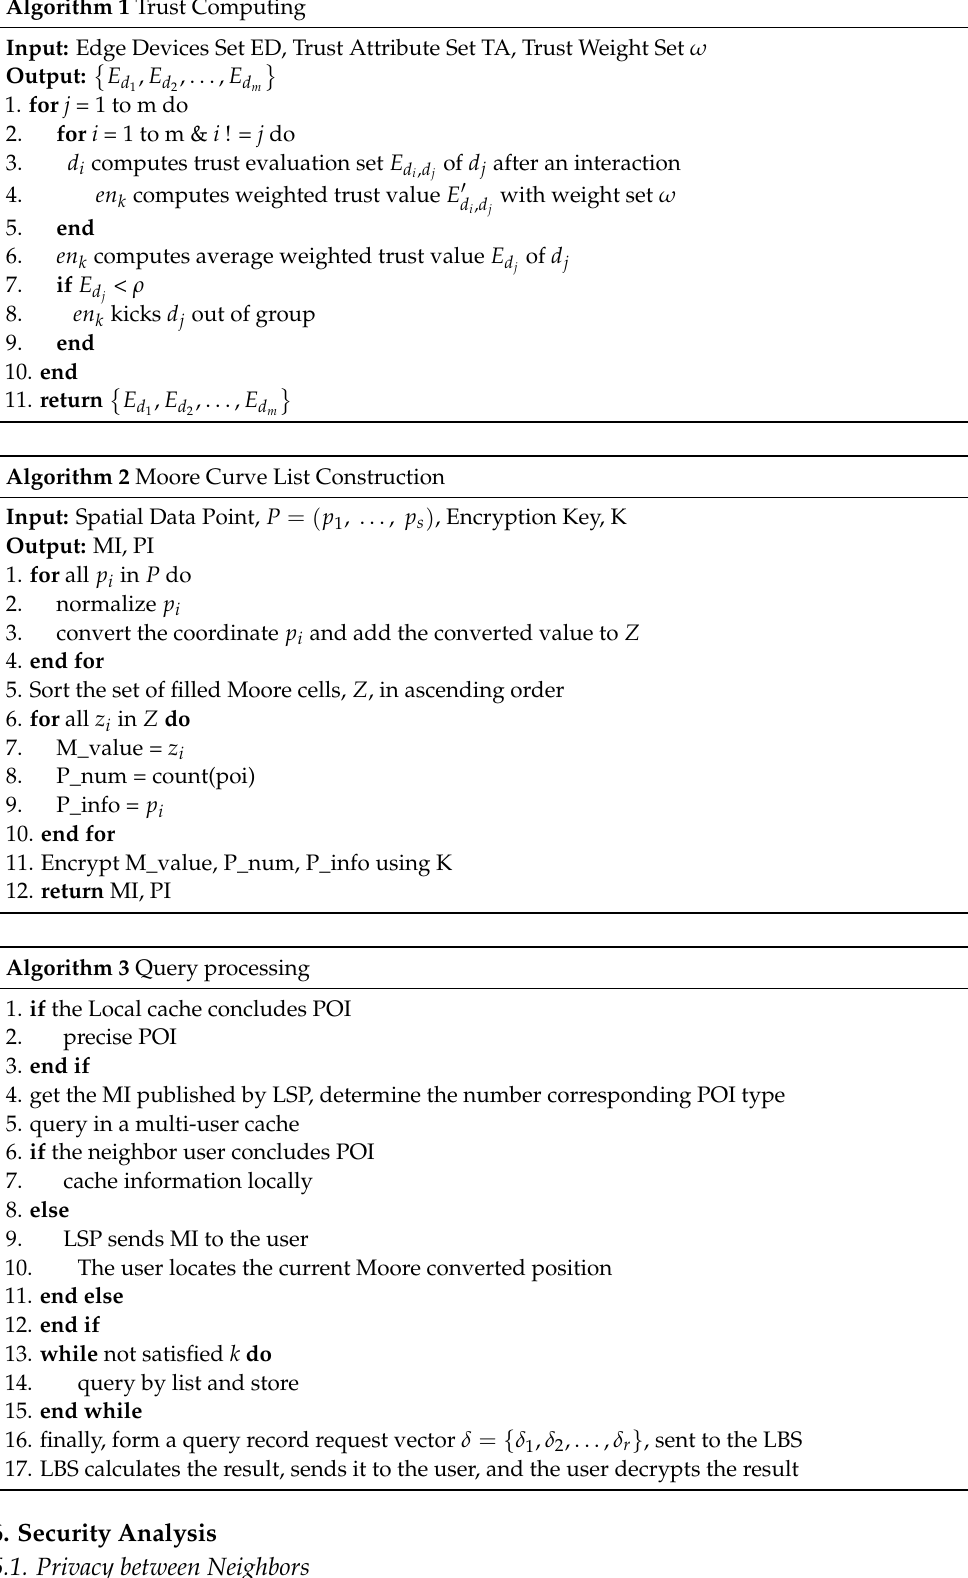
Algorithm 1 Trust Computing